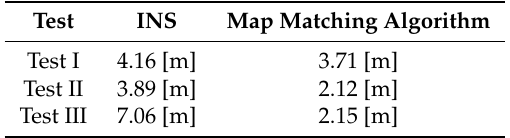
Table 3. Summary of maximal error at a